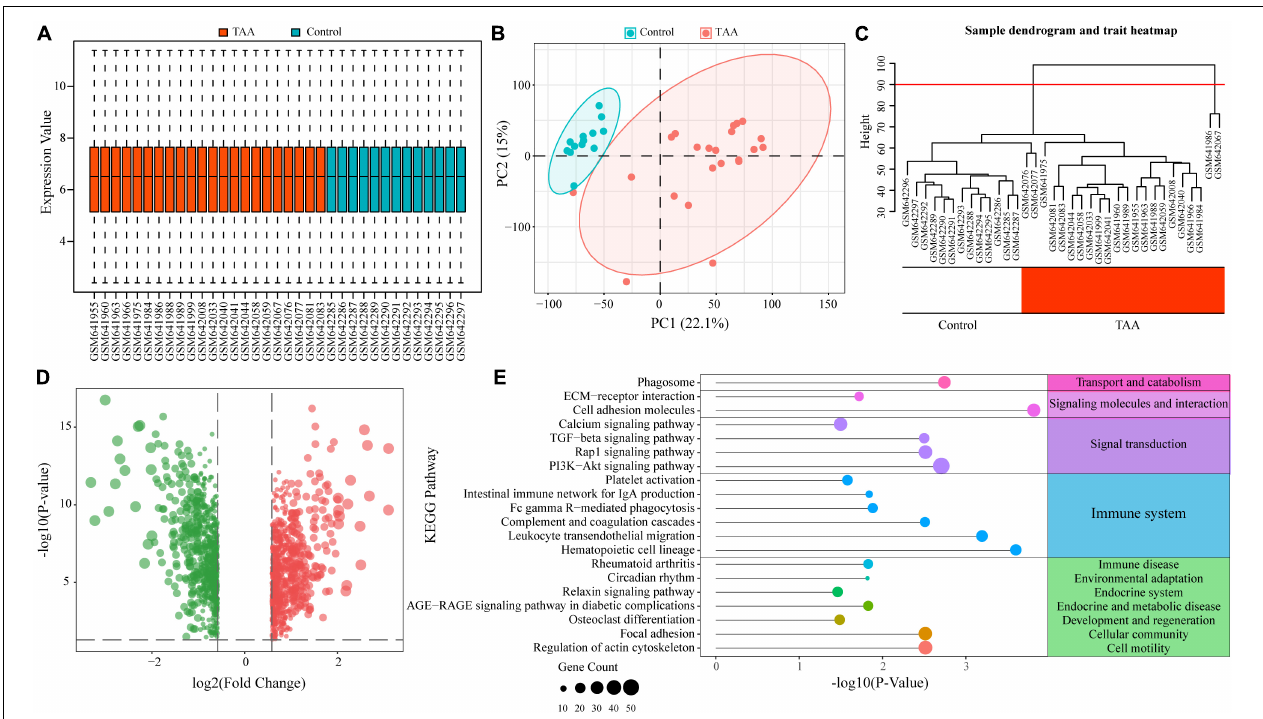
FIGURE 1 | Functional enrichment analysis of differentially expressed genes (DEGs) in thoracic aortic aneurysm (TAA). (A) Normalized data of the TAA dataset (GSE26155) are shown in a boxplot. (B) Two distinct group-bias clusters were identified by principal component analysis (PCA) based on the TAA dataset. (C) Sample clustering was performed to detect outliers. Two samples (GSM641986 and GSM642067) were excluded from the TAA dataset. The red line represents the cutoff of data filtering during data preprocessing. (D) DEGs between TAA and controls are shown in a volcano plot. The red and green nodes represent upregulated and downregulated DEGs, respectively. (E) KEGG enrichment analysis of the DEGs identified multiple immune-related pathways in TAA.